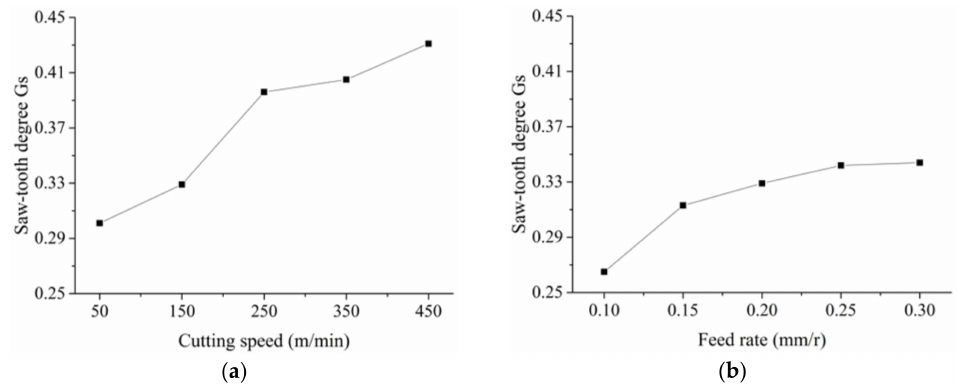
Figure 7. Influence of the cutting speed and the feed rate on the saw-tooth degree G s : ( a ) f r = 0.2 mm/r, a p = 0.4 mm; ( b ) v s = 150 m/min, a p = 0.4